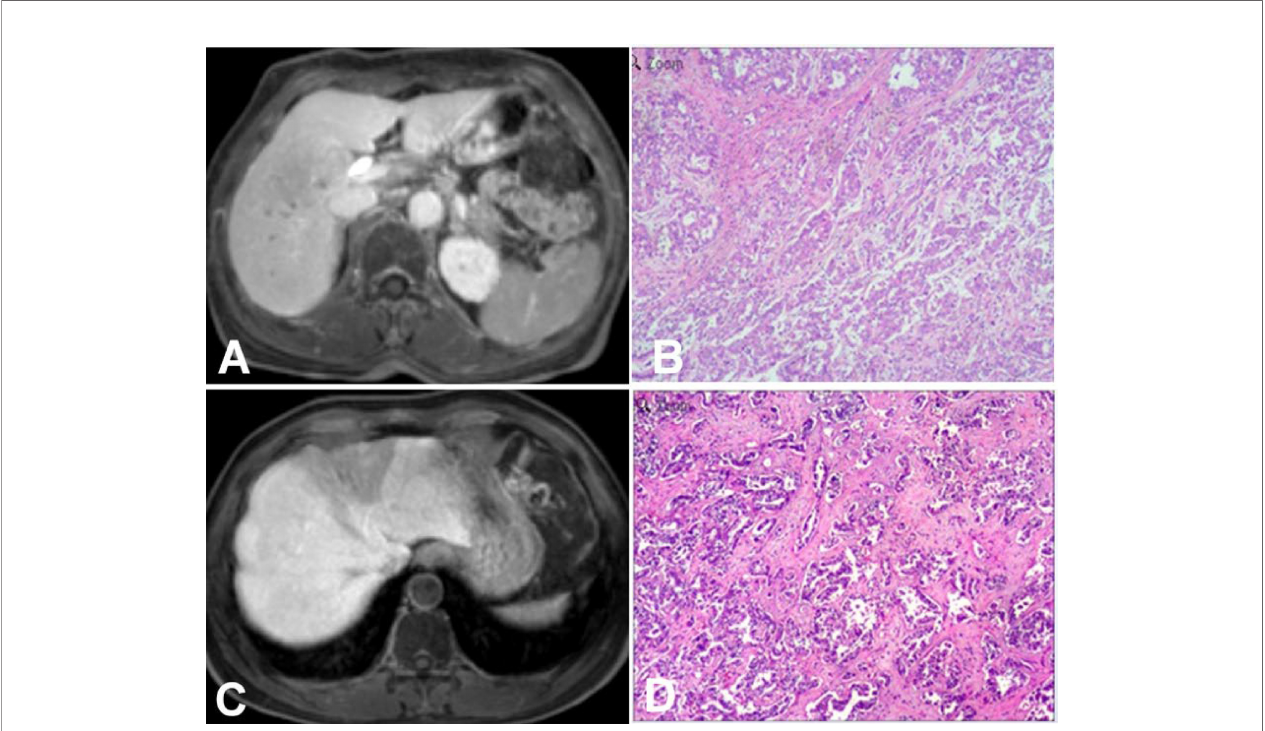
FIGURE 4 | Intrahepatic mass-forming cholangiocarcinomas (IMCCs) on magnetic resonance imaging (MRI) in the hepatobiliary phase (HBP). (A, B) An IMCC lesion was demonstrated as hypointense signal intensity on HBP MRI with a blurred boundary but no hypointense signal ring at the lesion edge (A) , and pathological staining showed that the IMCC was moderately differentiated (B) . (C, D) An IMCC lesion was demonstrated as hypointense signal intensity on HBP MRI with a clear boundary but no hypointense signal ring at the lesion edge (C) , and pathological staining showed that the IMCC was well differentiated (D) . Pathological staining: